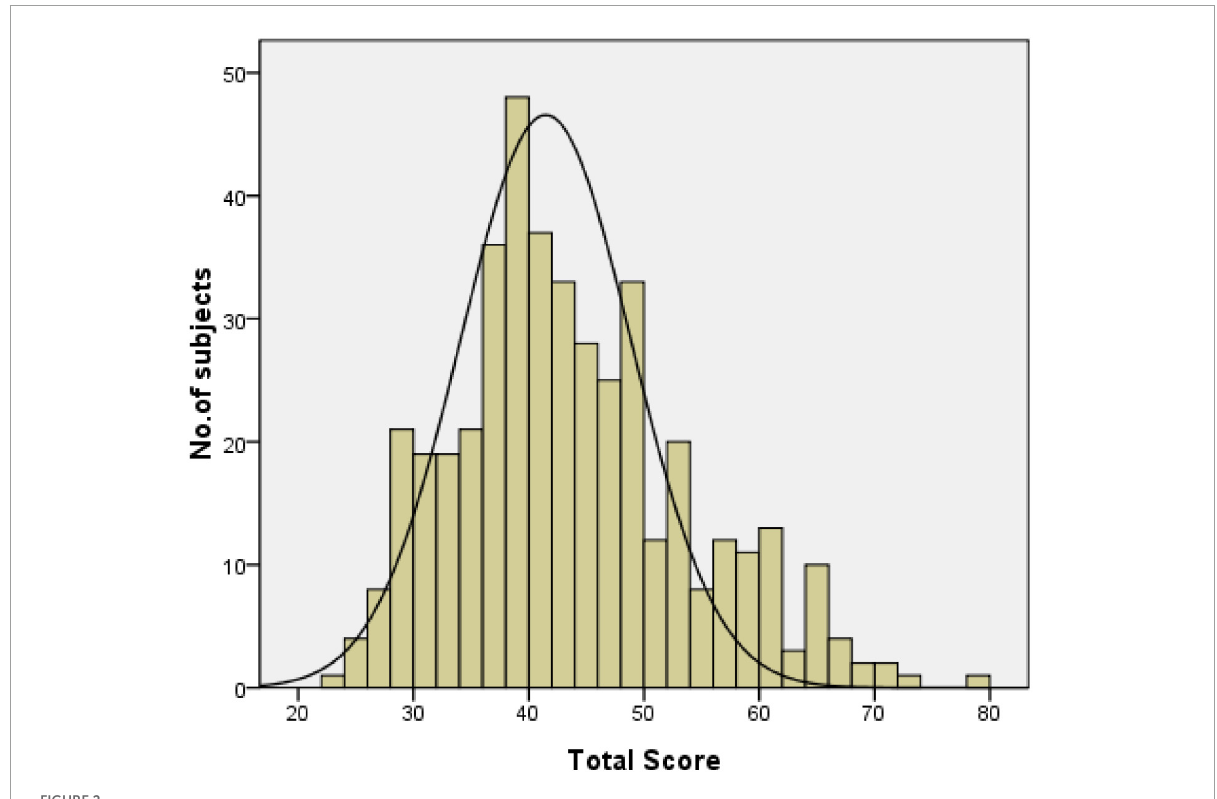
FIGURE2 Distribution of the SDSC-I total